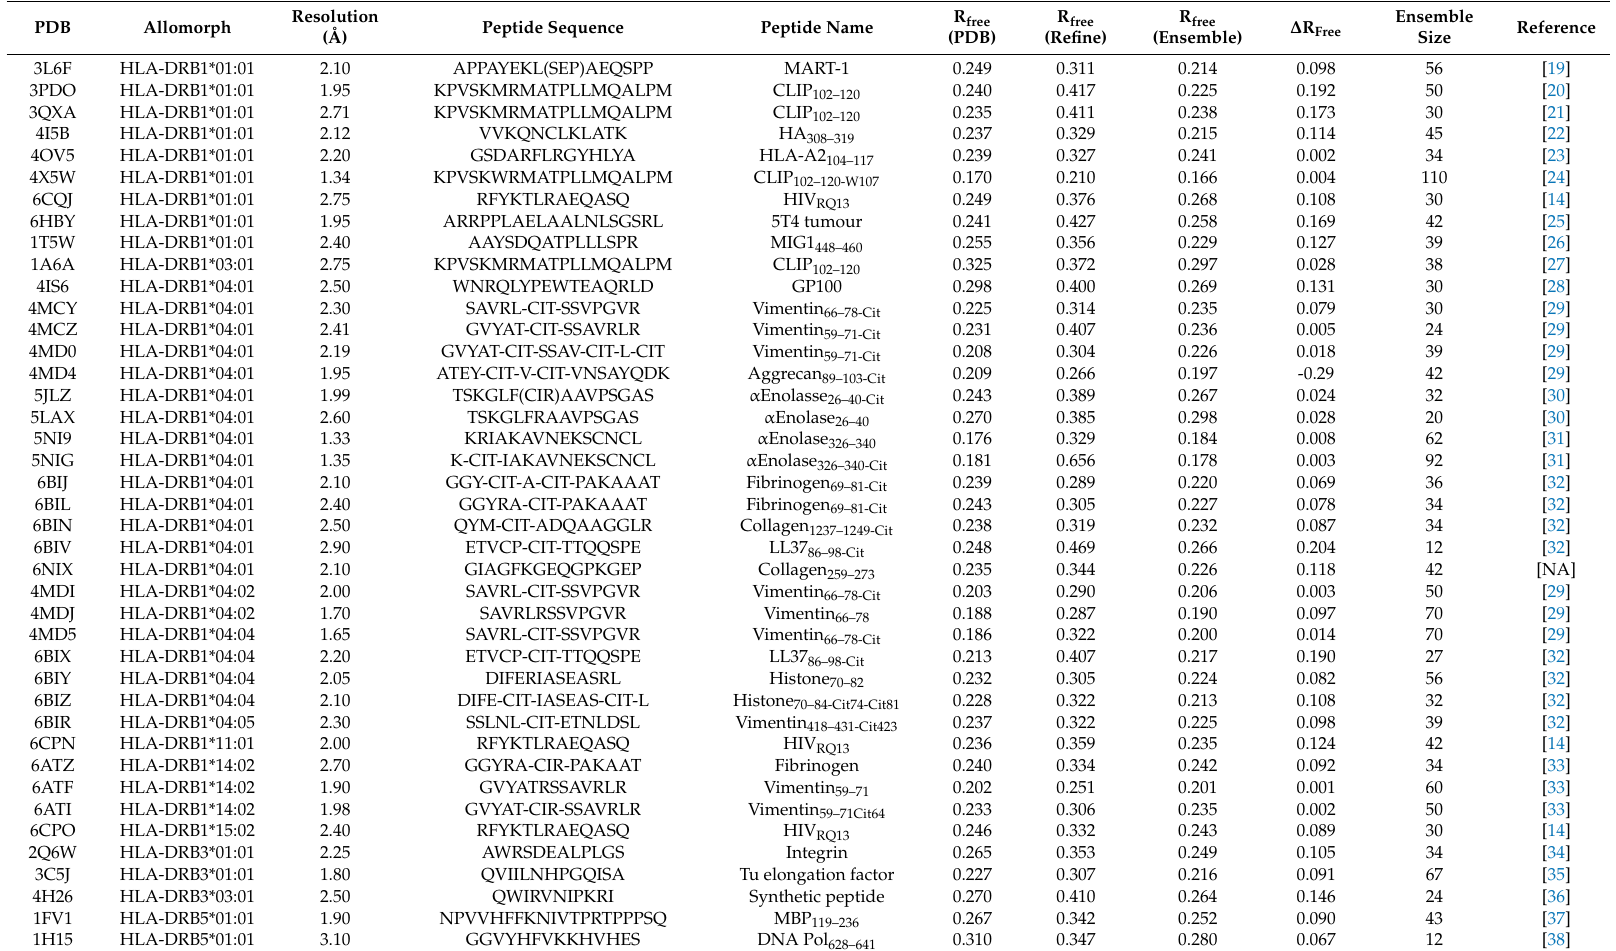
Table 1. pHLA-DR structures investigated by ensemble